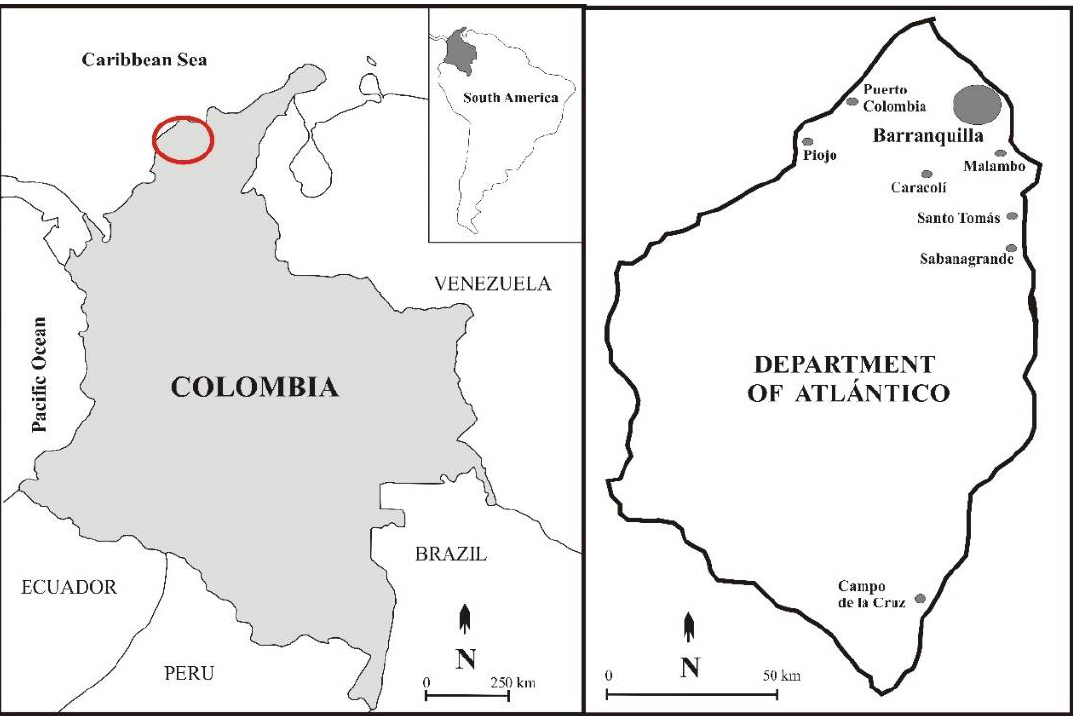
Figure 1. Department of Atlántico region in Colombia. On the left, the Colombia map with a red mark of sample region. On the right, the Department of Atlántico with the name sampling areas/towns.